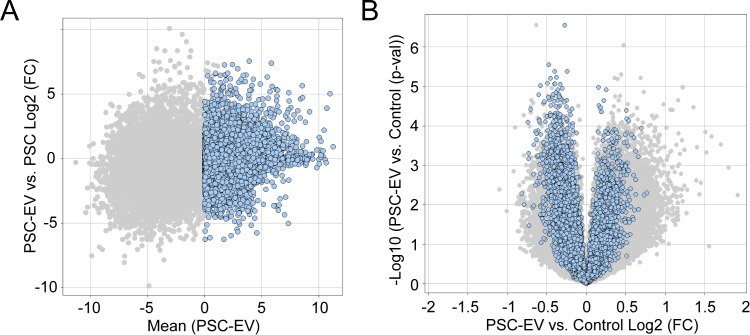
Distribution of PSC-EV associated transcripts within control- or EV-treated BMSC.(A) Identification of transcripts within PSC-EV. Minus versus average (MvA) plots of all transcripts in RNA sequencing of three PSC-EV samples. Blue dots indicate 7,789 PSC-EV transcripts with a mean FPKM >0. (B) Next, the distribution of these 7,789 PSC-EV transcripts were examined among recipient BMSC 48 hr after treatment with PSC-EV or control. Volcano plot of PSC-EV-treated versus control-treated BMSC. All transcripts are shown in light grey, while the 7,789 PSC-EV transcripts are shown in blue. Of these, approximately half were over-represented in PSC-EV treated cells (47.22%, 3678 transcripts). PSC: perivascular stem cell; PSC-EV: perivascular stem cell-derived extracellular vesicle.